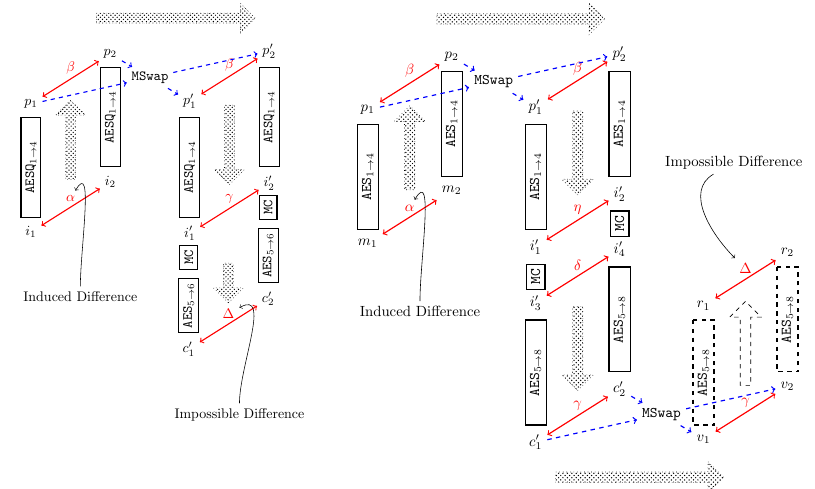
Figure 12: Impossible Differential Yoyo based Known-Key distinguisher for 6/8-round